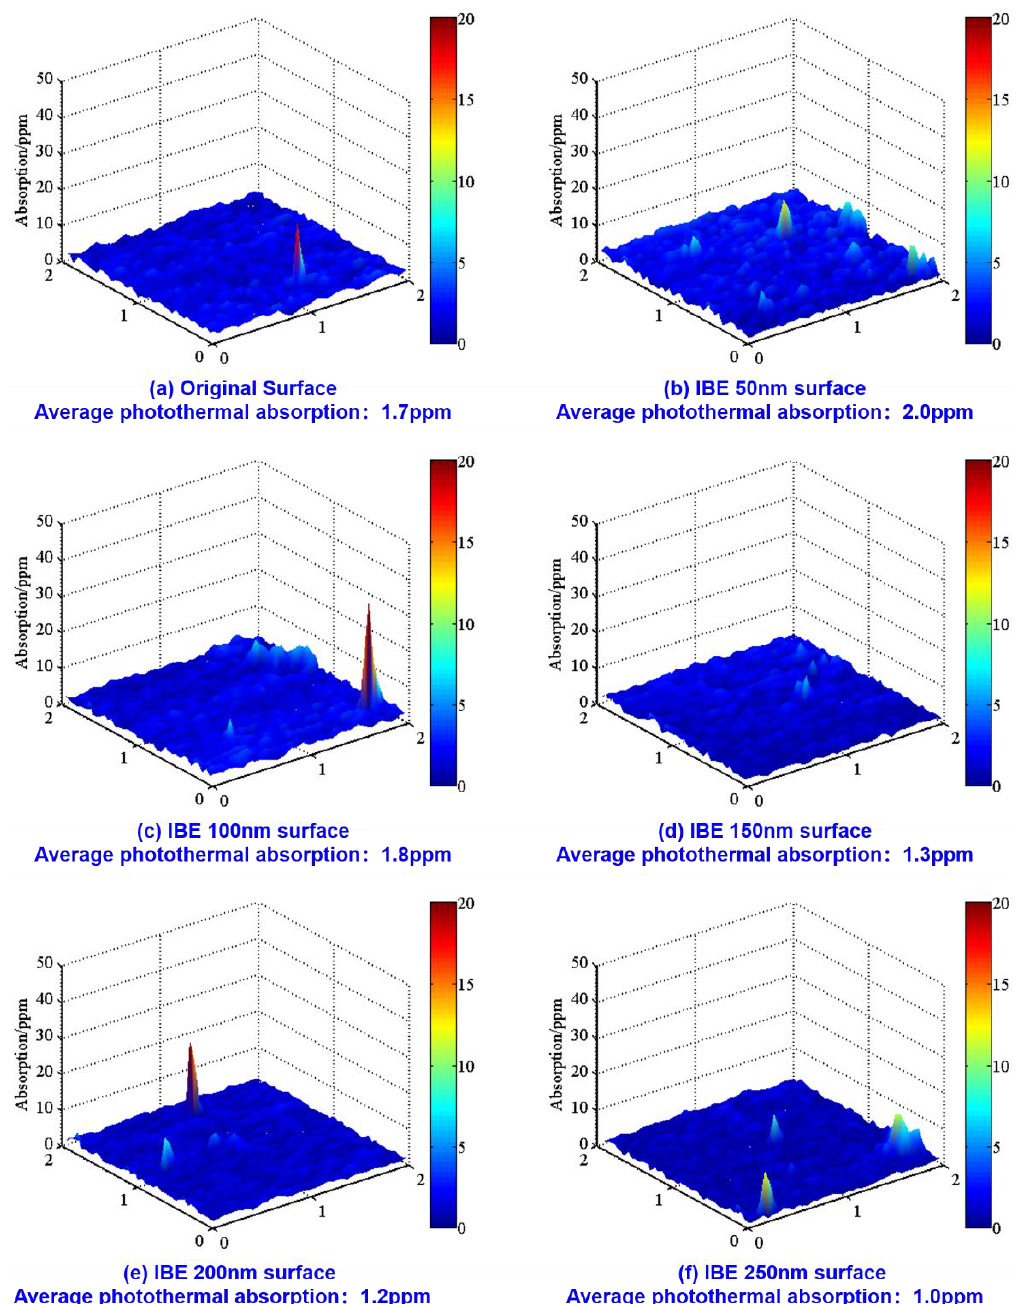
Figure 5. Photothermal absorption distribution in six zones at various IBE depths: ( a ) Original surface: 1.7 ppm; ( b ) IBE 50 nm surface: 2.0 ppm; ( c ) IBE 100 nm surface: 1.8 ppm; ( d ) IBE 150 nm surface: 1.3 ppm; ( e ) IBE 200 nm surface: 1.2 ppm; ( f ) IBE 250 nm surface: 1.0 ppm.